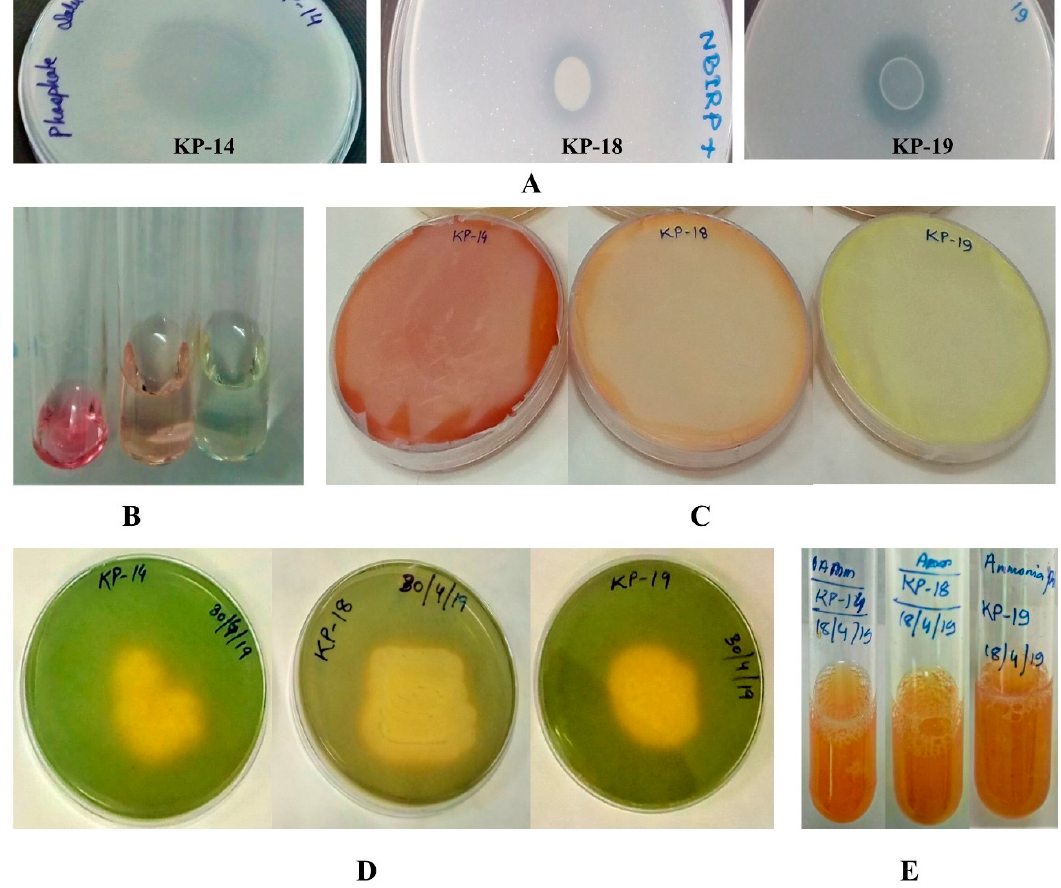
Figure 2. Evidence of different plant growth promoting (PGP) attributes for selected isolates KP14, KP18, and KP19: ( A ) phosphate solubilization, confirmed by the clear halo around the culture; ( B ) IAA production, confirmed by the pink color development in the reaction mixture; ( C ) HCN production (brown color development in the picric acid-soaked filter paper); ( D ) siderophore production, confirmed by yellow halo on CAS agar plates; and ( E ) ammonia production, confirmed by the brown color development in the reaction mixture. Table 4. Plant growth-promoting characteristics exhibited by selected isolates: KP-14, KP-18, and KP19.